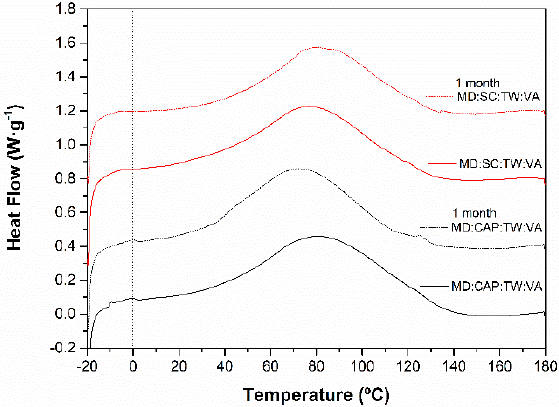
Figure 4. First heating DSC thermograms of MD:CAP:TW:VA and MD:SC:TW:VA powders after 1-month storage.